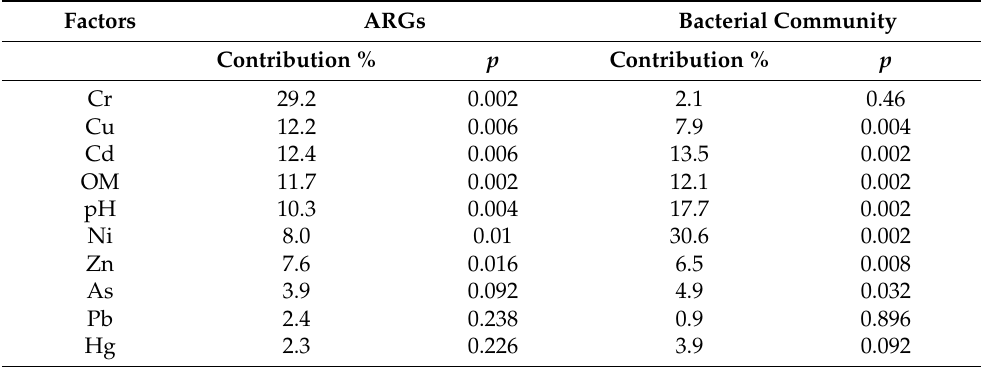
Figure 6. RDA of bacterial communities in different greenhouse soils. Table 1. Contributions of physicochemical properties and heavy metal concentrations on bacterial communities and ARGs based on RDA.